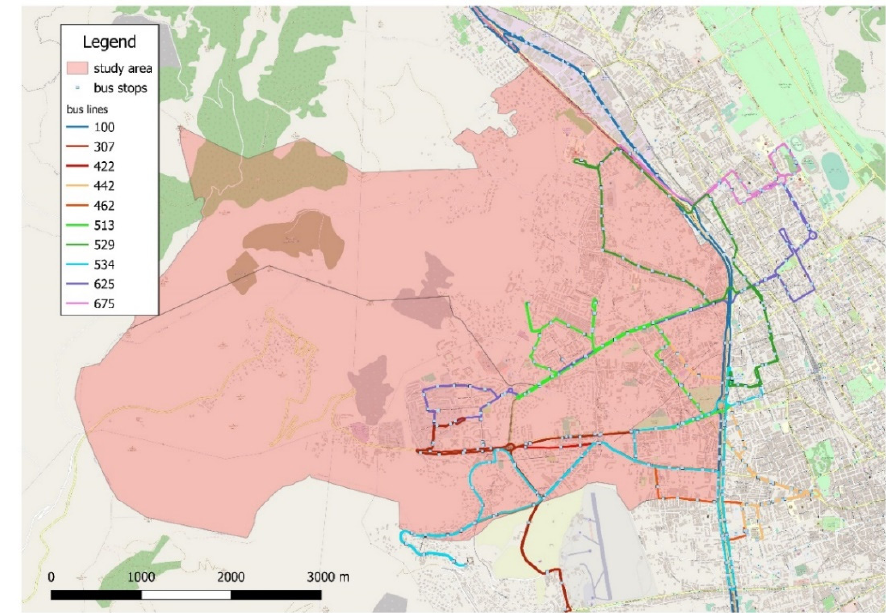
Figure 2. The bus lines in the study area.